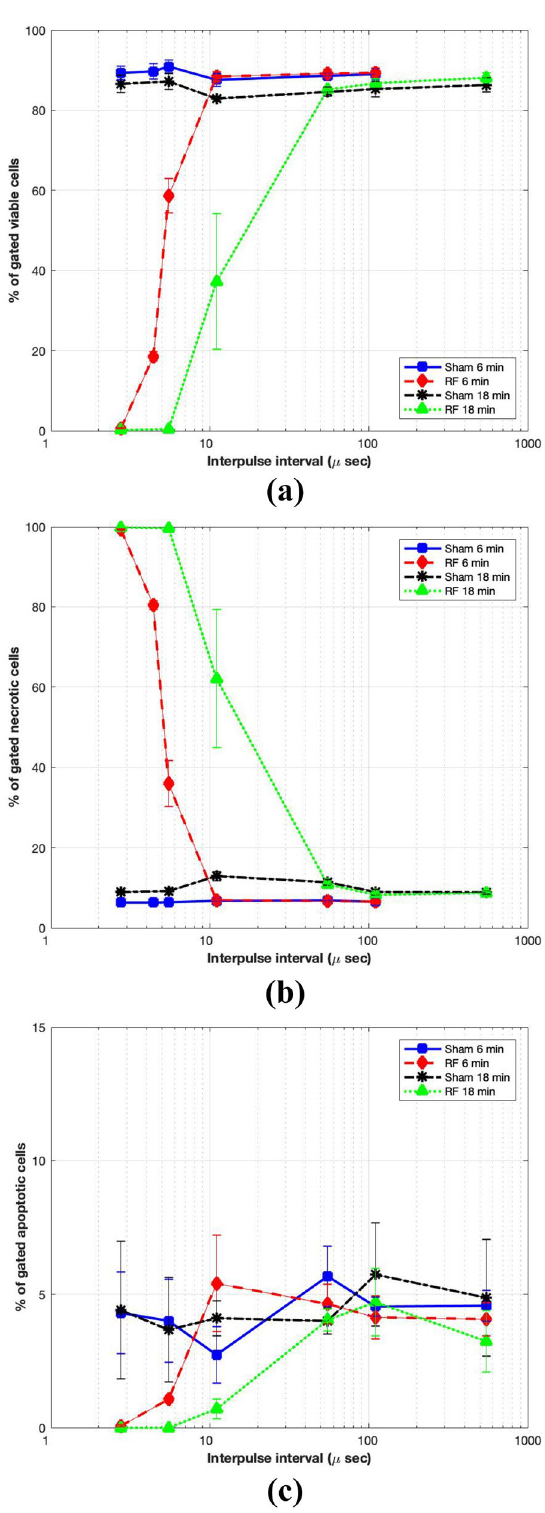
Figure 13. Effect of 6/18 min exposures to interpulse intervals of 2.75, 4.4, 5.5, 11, 55 and 110 μs (RF 1.2 GHz, 550 ns pulse) on cell viability (data shown represent the